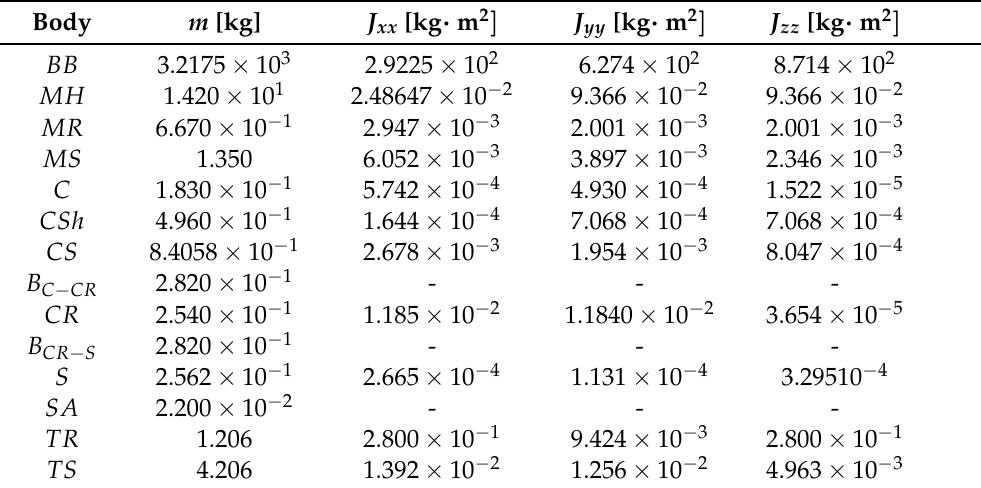
Table 1. Mechanical properties expressed with respect to the center of gravity of each individual body.